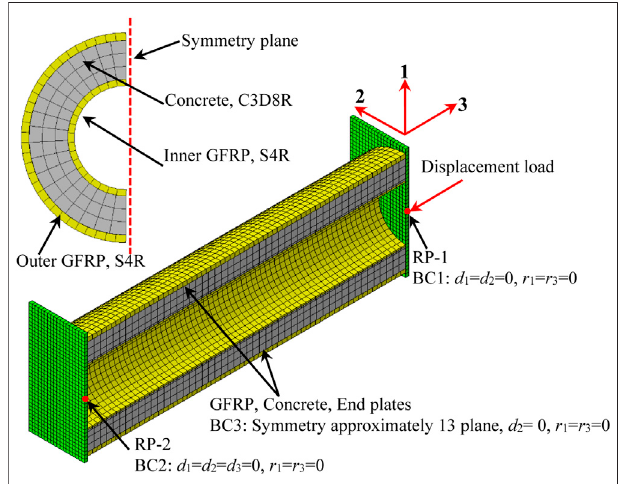
FIGURE 7 | Schematic diagram of the proposed FE